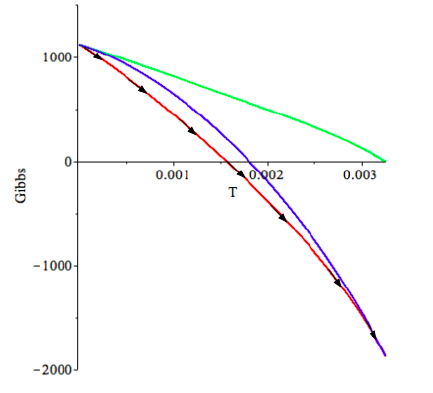
Figure 6 . Canonical Gibbs Free Energy( CGFE): the green curve represents the CGFE correspond- ing only to the black hole, the blue curve represents the CGFE as measured at the cosmological horizon r c , the red curve is of the CGFE of the total system i.e. of the black hole in a the de Sitter heat bath . All curves are plotted for P = (cid:0) 0 : 0001 and Q =